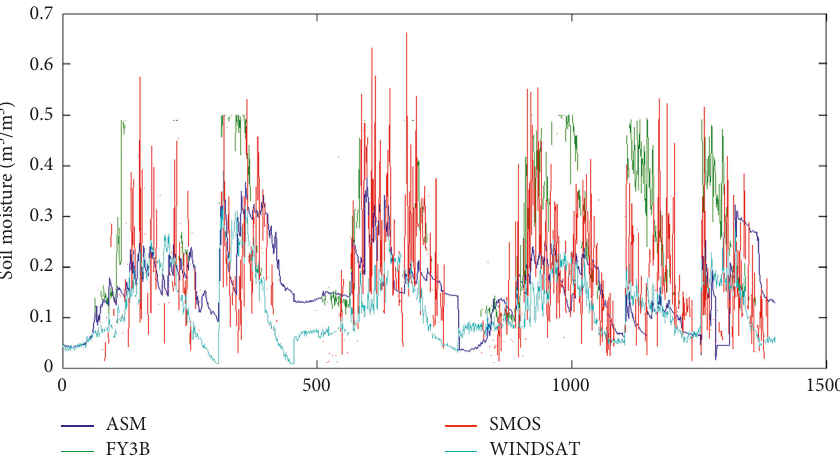
Figure 1: Northeast region ground-based observational data (ASM) and remote sensing data from the three satellites (FY3B, SMOS, and WINDSAT).